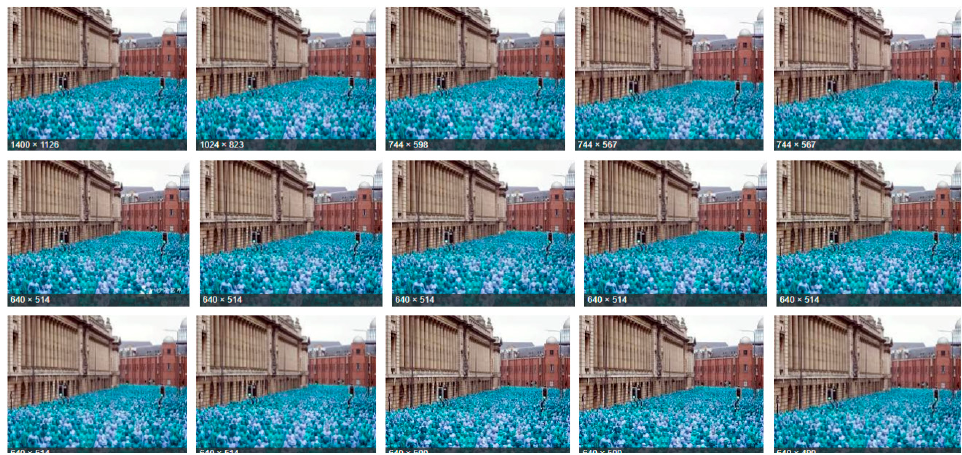
Figure 15. Collective art performance by Spencer Tunick. “ Sea of Hull ” . Web